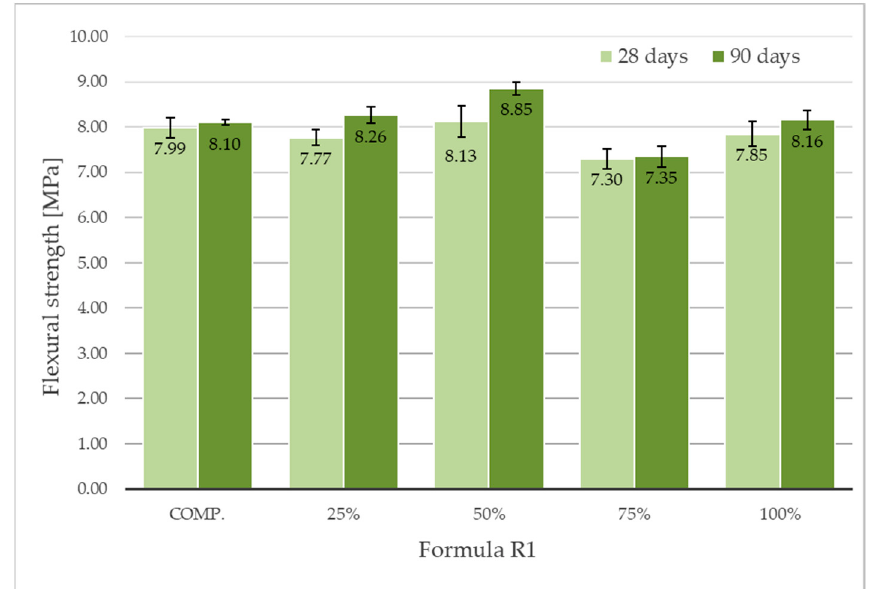
Figure 5. Flexural strength of Formula R1 with 25%, 50%, 75%, and 100% of mixing water replaced with waste sludge water from the CP.